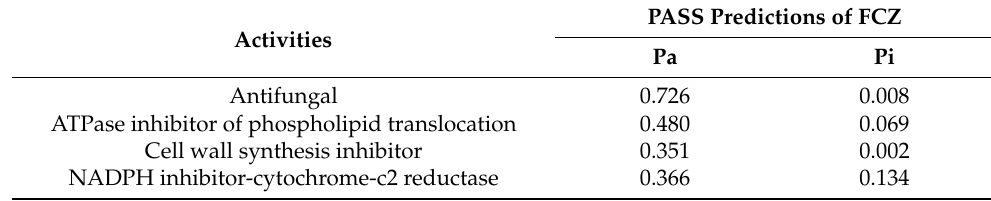
Table 2. In silico analysis of the biological activities of Fluconazole.